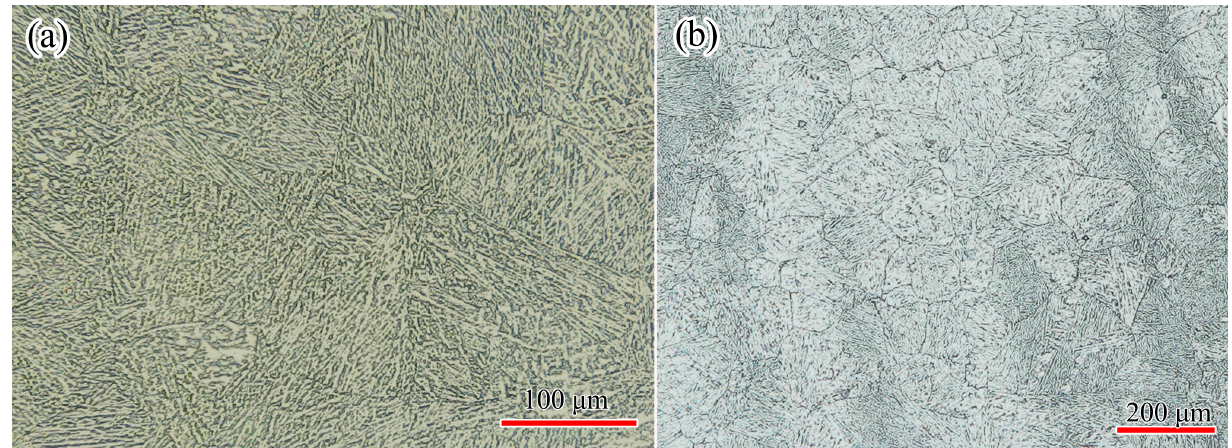
Figure 1. Microstructure of 300M steel in ( a ) as-received state, and ( b ) after tempering at 560 °C for 2 h.